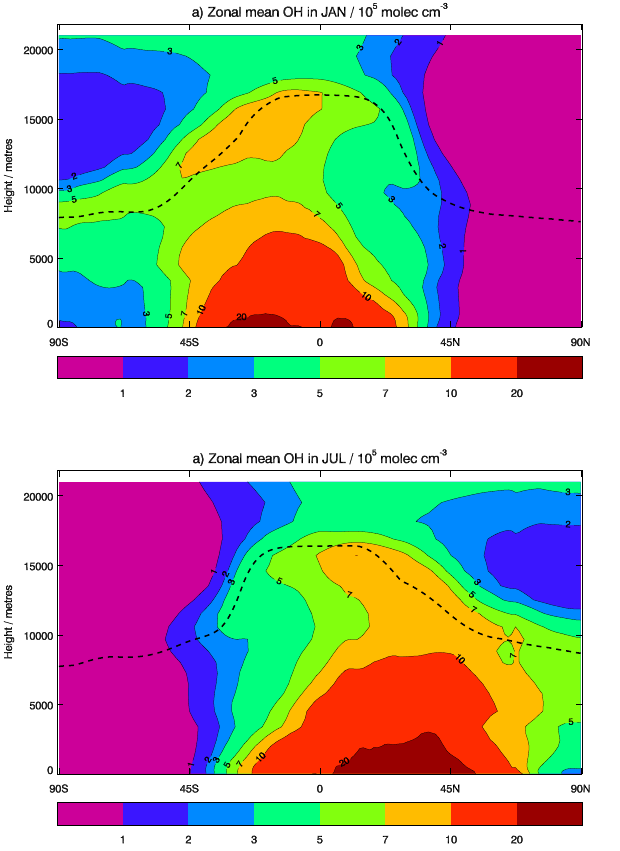
Fig. 23. Multi-annual monthly mean distribution of surface O 3 from the StdTrop chemistry scheme in the tropospheric configuration of the UKCA model in (a) January and (b) July. 95